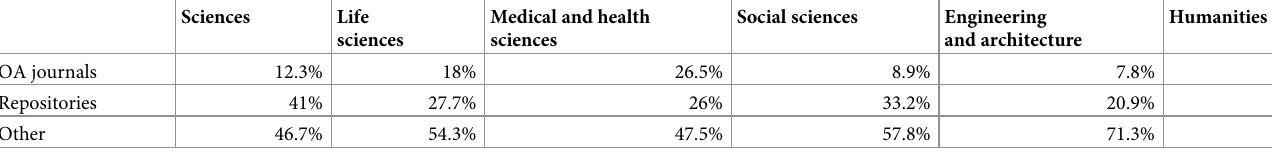
Table 7. Locations of the documents found, according to thematic